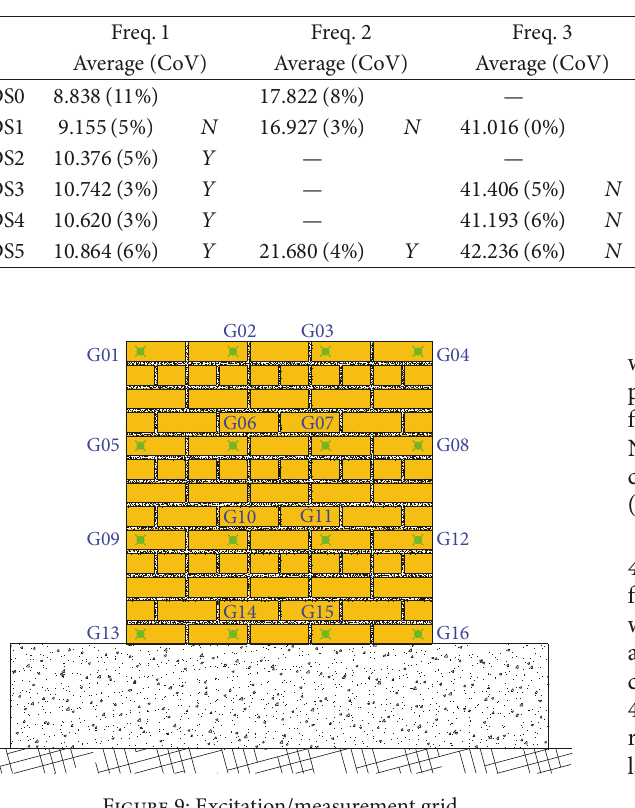
Table 5: Modal frequencies detected by applying FDD method.